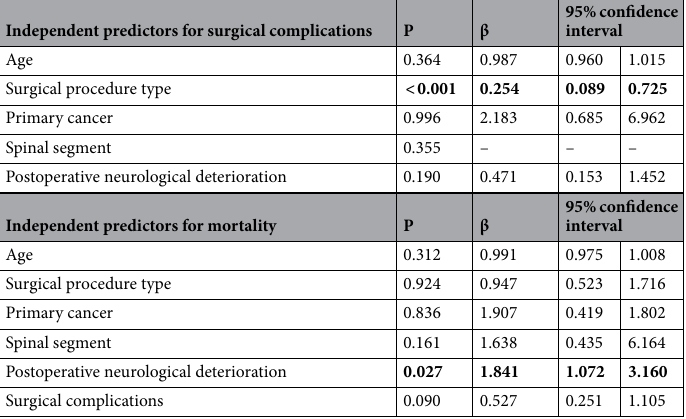
Table 4. Binomial logistic regression of mortality during follow-up. P level of significance. β regression coefficient. Bold type indicates statistically significant predictors.